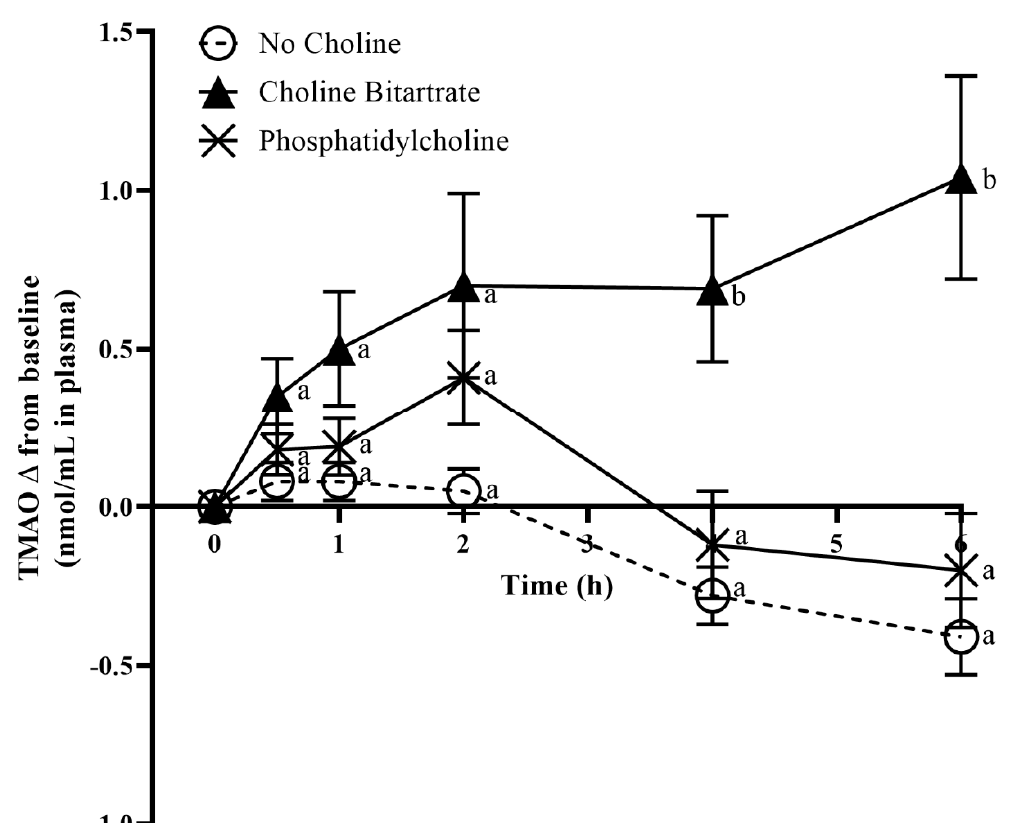
Figure 2. Effects of the study meals on plasma trimethylamine- N -oxide (TMAO) change from 0 min study-baseline across the 6-h study period. Different letter superscripts show a significant effect of study meal at each time point determined by one-way ANOVA, Tukey-Kramer post hoc test. Values are mean ± SEM, n = 37 per study meal.